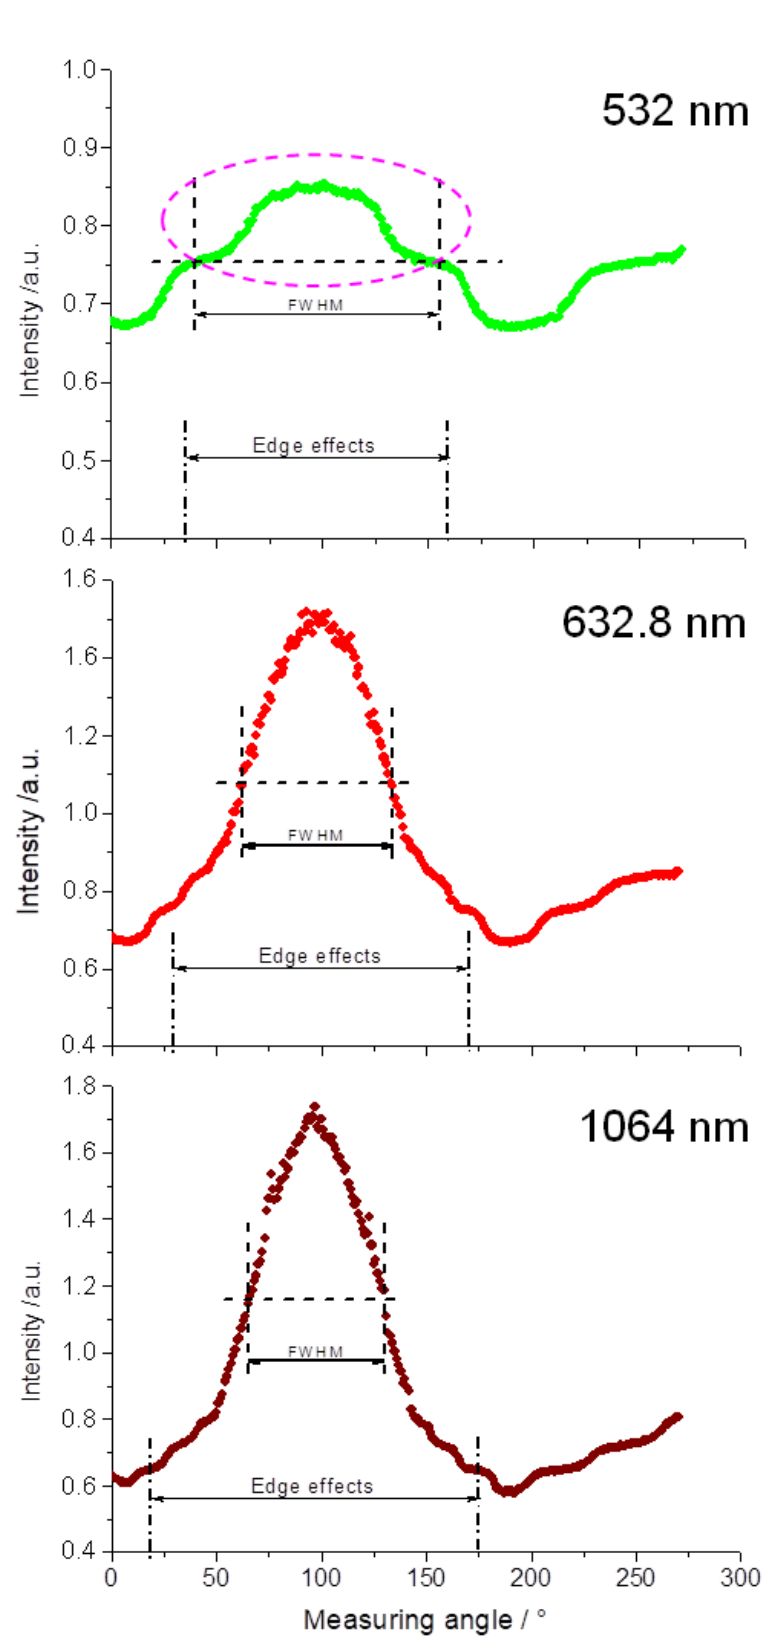
Figure 5. Line widths (FWHM) and edge effects for the various wavelengths measured on the ceramic base model. With increasing wavelengths, the line widths decrease whereas the edge effects increase. For the wavelength 532 nm, the line width and the width of the edge effects almost coincide. Therefore, the line width was determined above the edges (pink dashed oval).